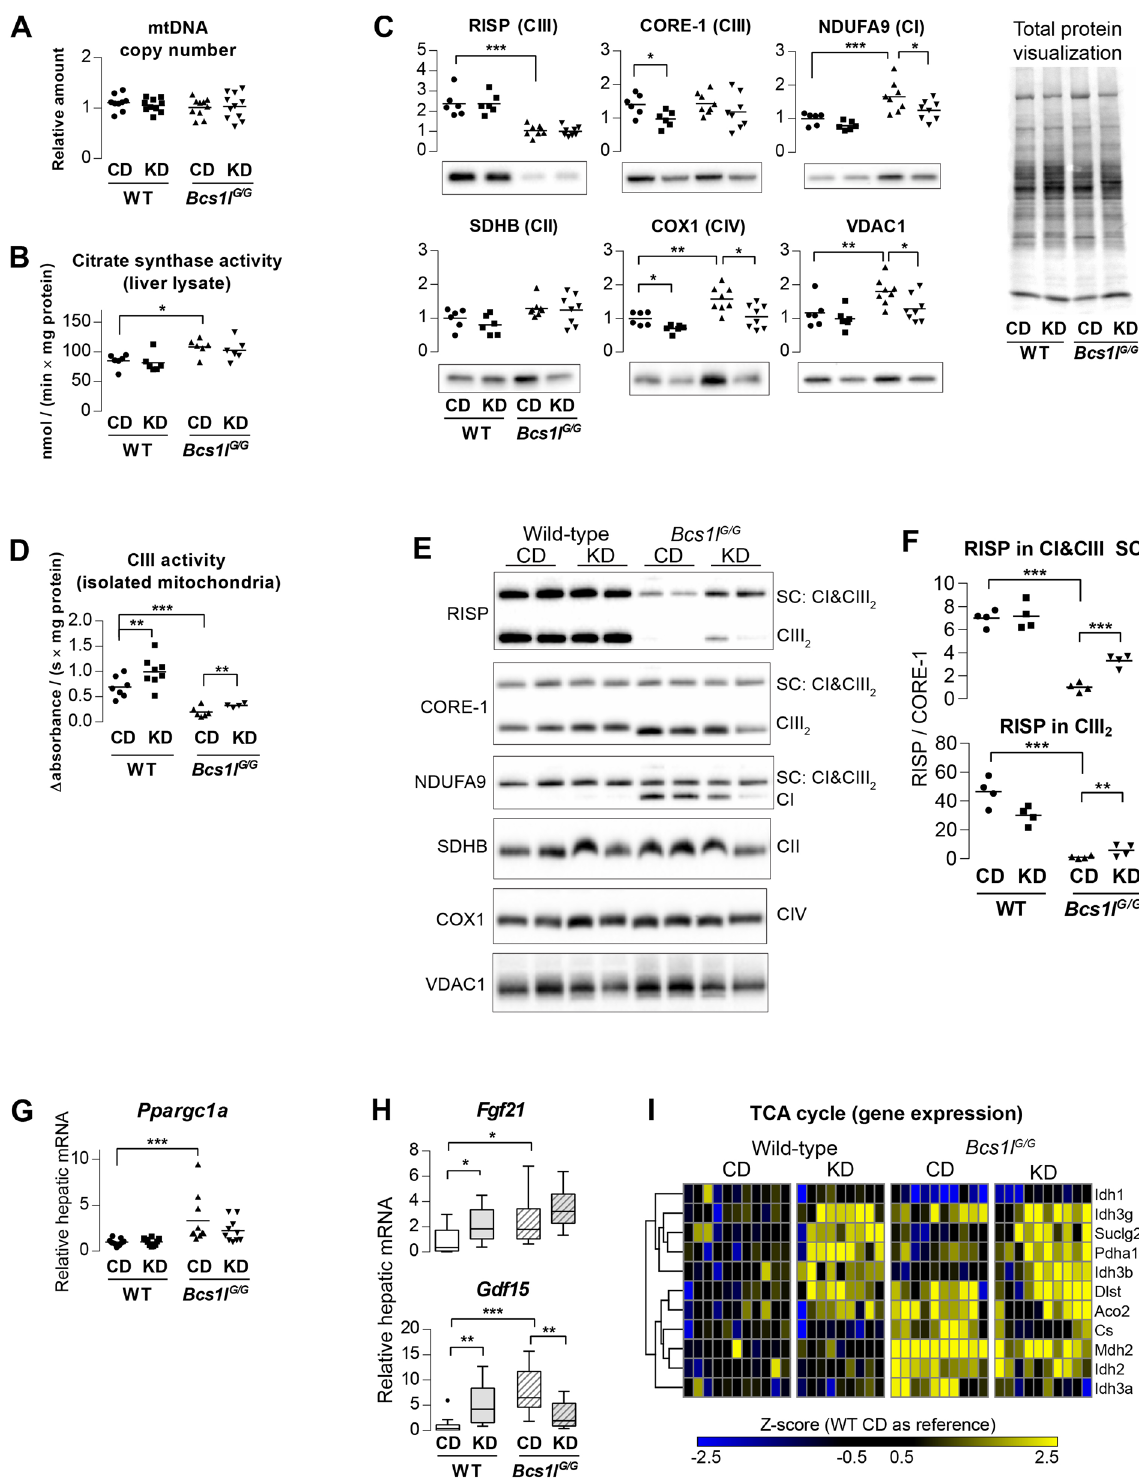
Figure 4. Ketogenic diet improves CIII assembly and activity but does not increase mitochondrial mass in Bcs1l G/G livers. ( A ) Liver mitochondrial DNA (mtDNA) relative to nuclear DNA. ( B ) Citrate synthase activity in liver lysate as a marker of mitochondria content. ( C ) Western blot analysis of RC proteins and VDAC1 (PORIN) in liver lysates. The data were normalized to total protein transferred to membrane as quantified from total protein staining. ( D ) Spectrophotometric analysis of CIII activity in isolated liver mitochondria. ( E ) Blue native polyacrylamide gel electrophoresis of digitonin-solubilized mitochondria and subsequent Western blot and analysis of intact RC complexes and supercomplexes (SC). (F ) Quantification of RISP amount in CIII dimer (CIII 2 ) and in supercomplex containing CI and CIII 2 . The band intensities were normalized to CIII subunit CORE-1. ( G ) Relative expression of Ppargc1a , a master regulator of mitochondrial biogenesis. ( H )